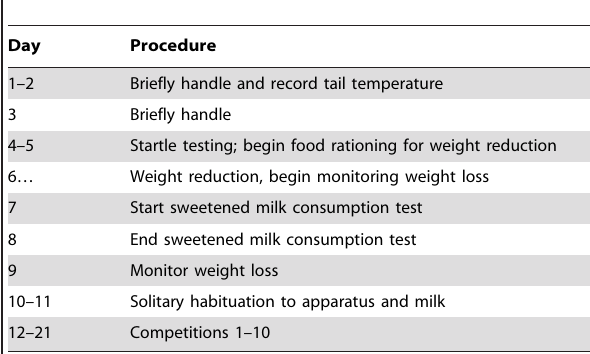
Table 1. Protocol for the primary